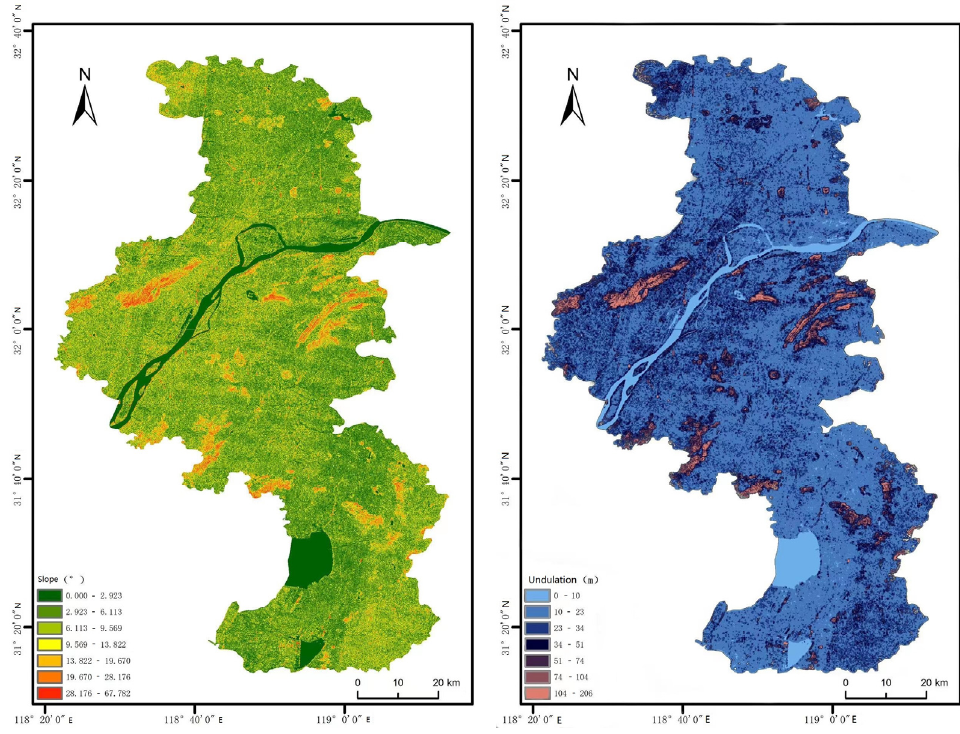
Figure 2. Slope grading layer and terrain undulation grading layer.